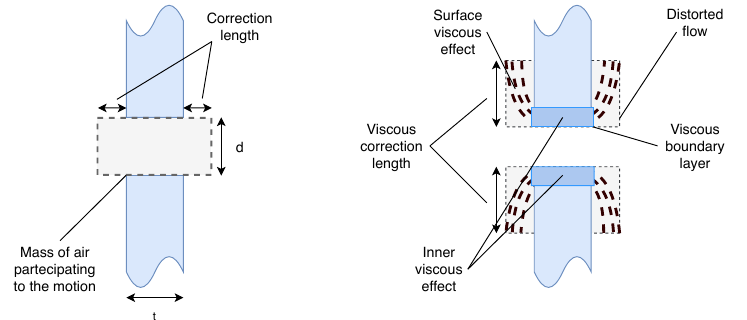
Figure 4. Physical phenomena involved in an MPP: surface viscous effects and inner viscous